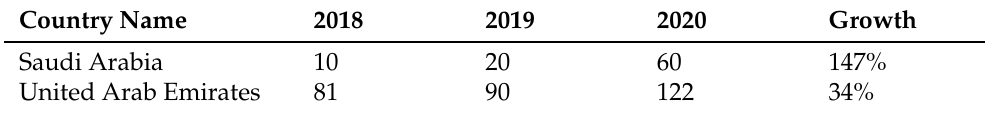
Table 1. Growth in numbers of startups in Saudi Arabia and UAE (source: Crunchbase). Country